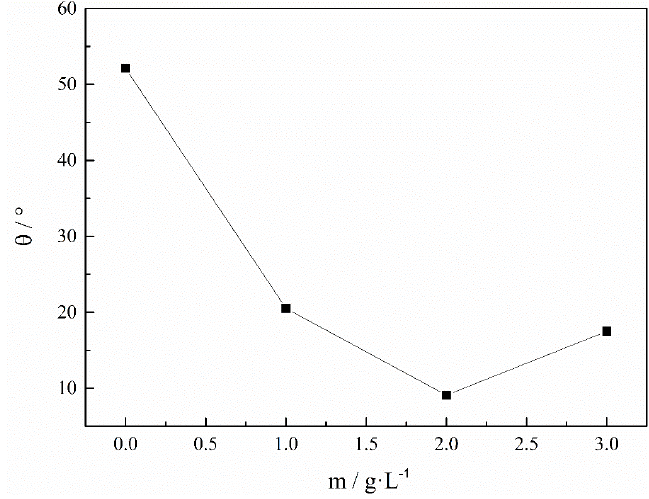
Figure 8. Effect of C 7 H 5 NO 3 SNa on the rolling angle ( θ ) of Fe-Ni magnetic film. pH = 2, 30 °C.